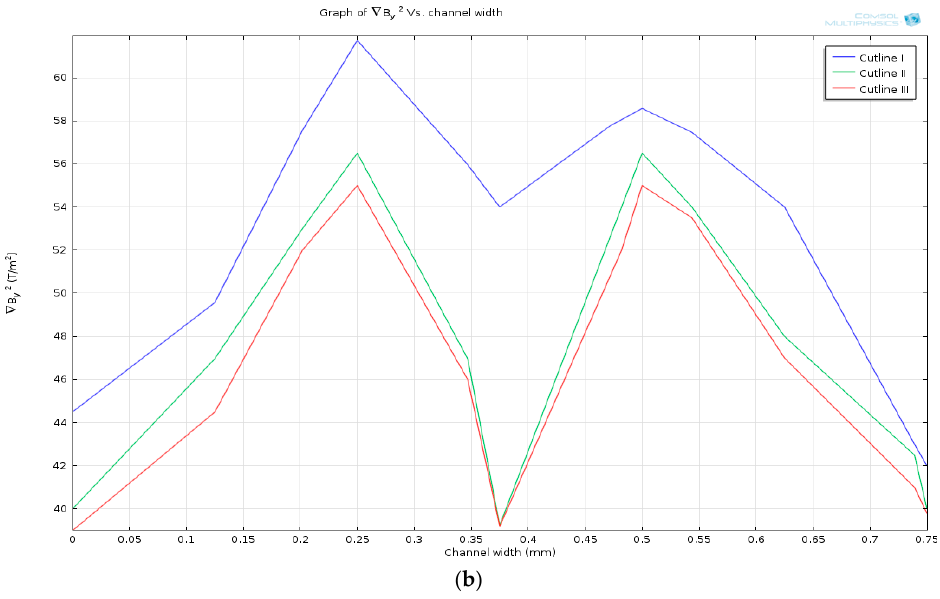
Figure 6. Magnetic field gradient analysis: ( a ) Surface plot; ( b ) Graph of ∇ B y 2 across the channel width.